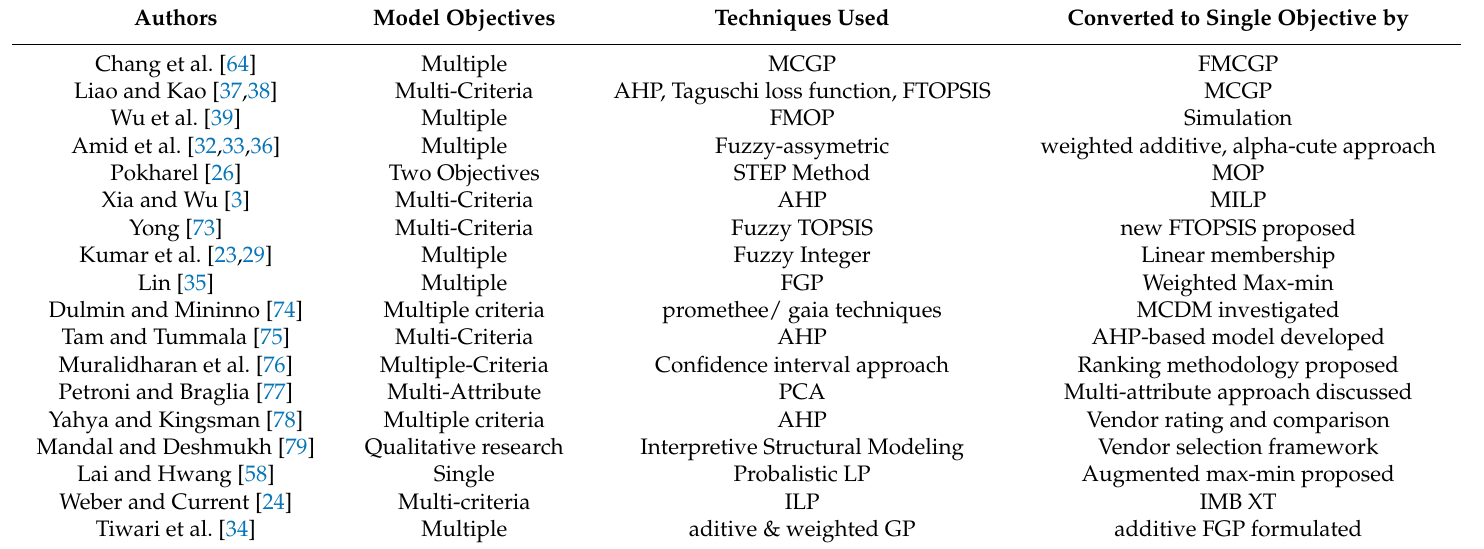
Table 2. Summary of Literature